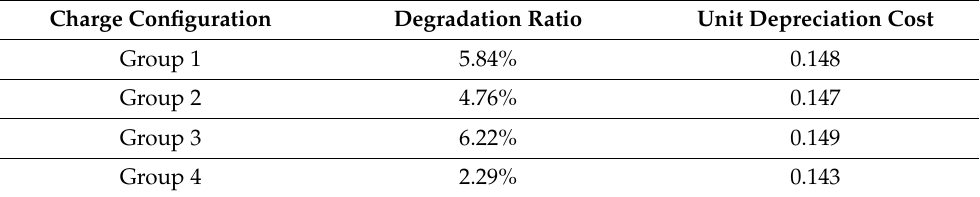
Table 10. Battery depreciation parameter as a function of the degradation